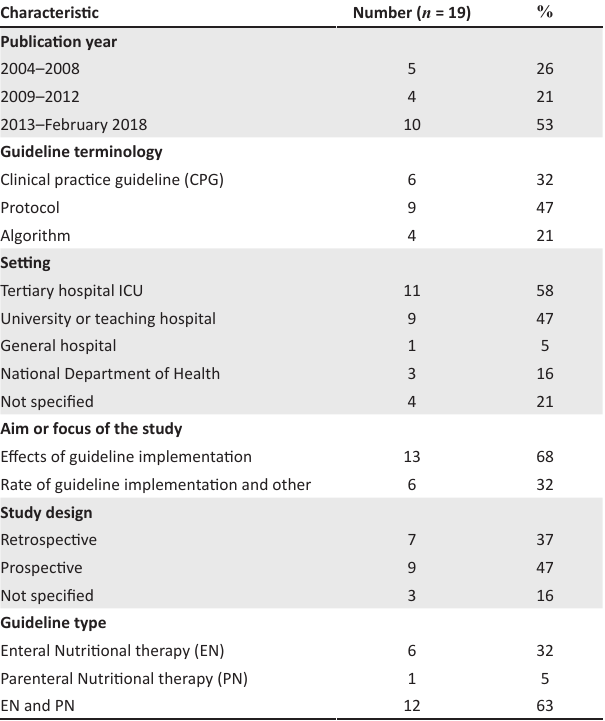
FIGURE 1: PRISMA flow diagram showing literature search and selection of studies. TABLE 3: Summary of included